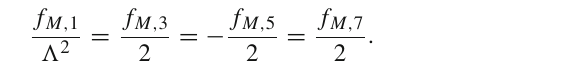
Table 1 Set of genuine aQGC operators of dimension-8 for WW